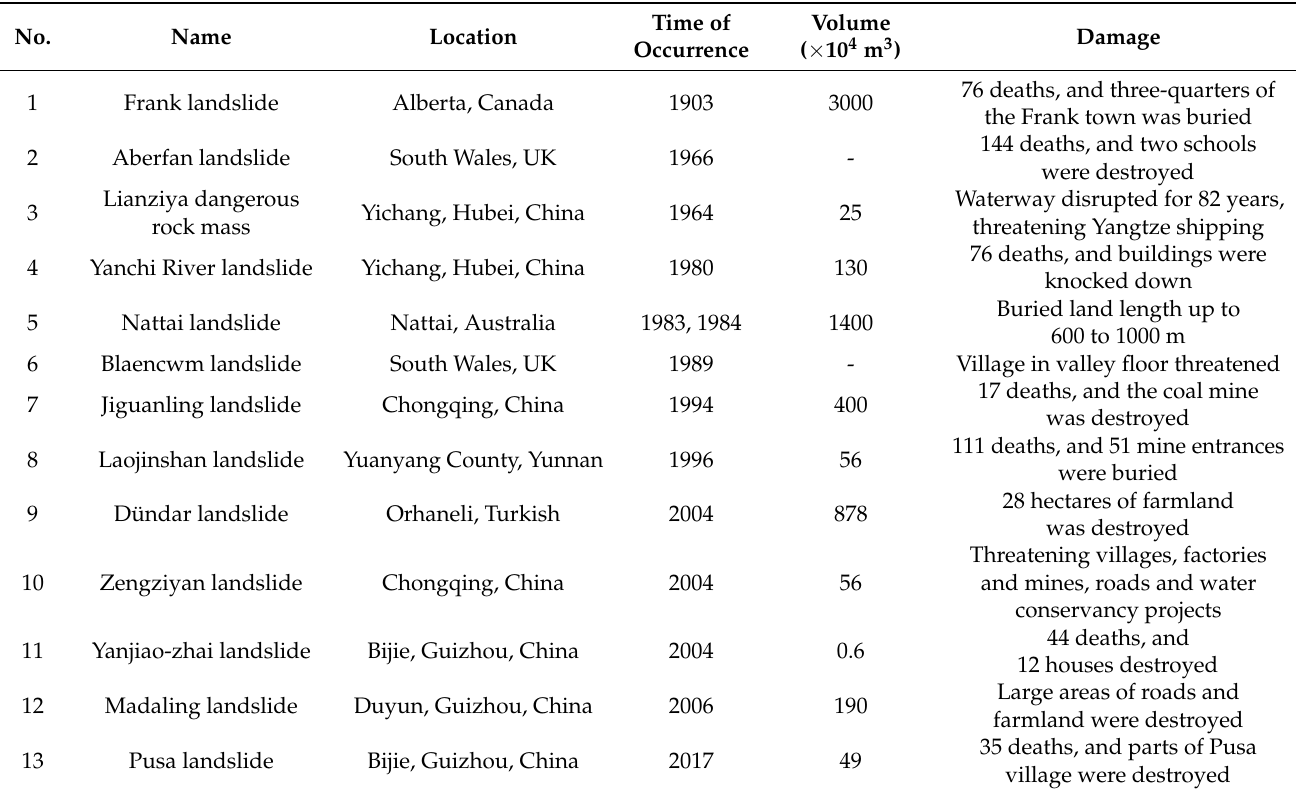
Table 1. List of typical landslides induced by underground